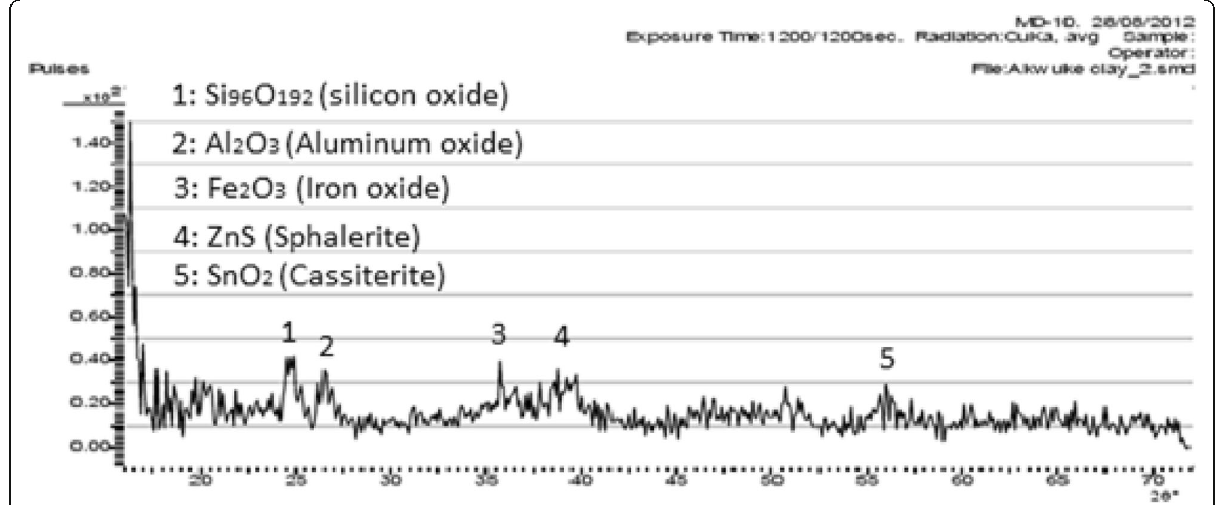
Fig. 8 XRD pattern of Akwuke ore with identified